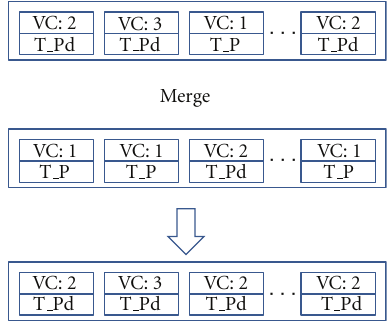
Figure 1: Merging